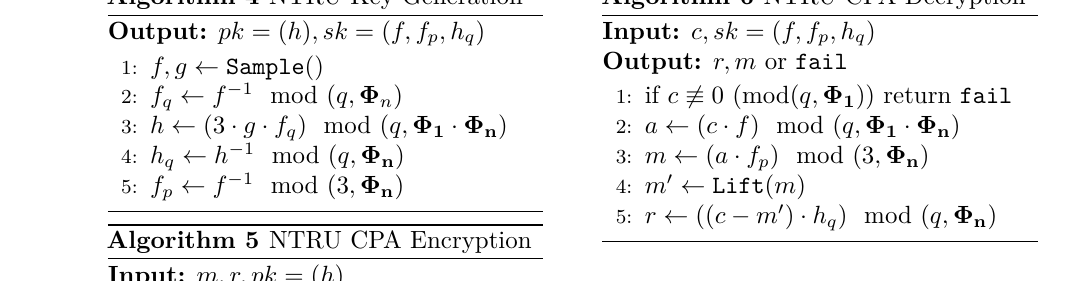
Algorithm 6 NTRU CPA